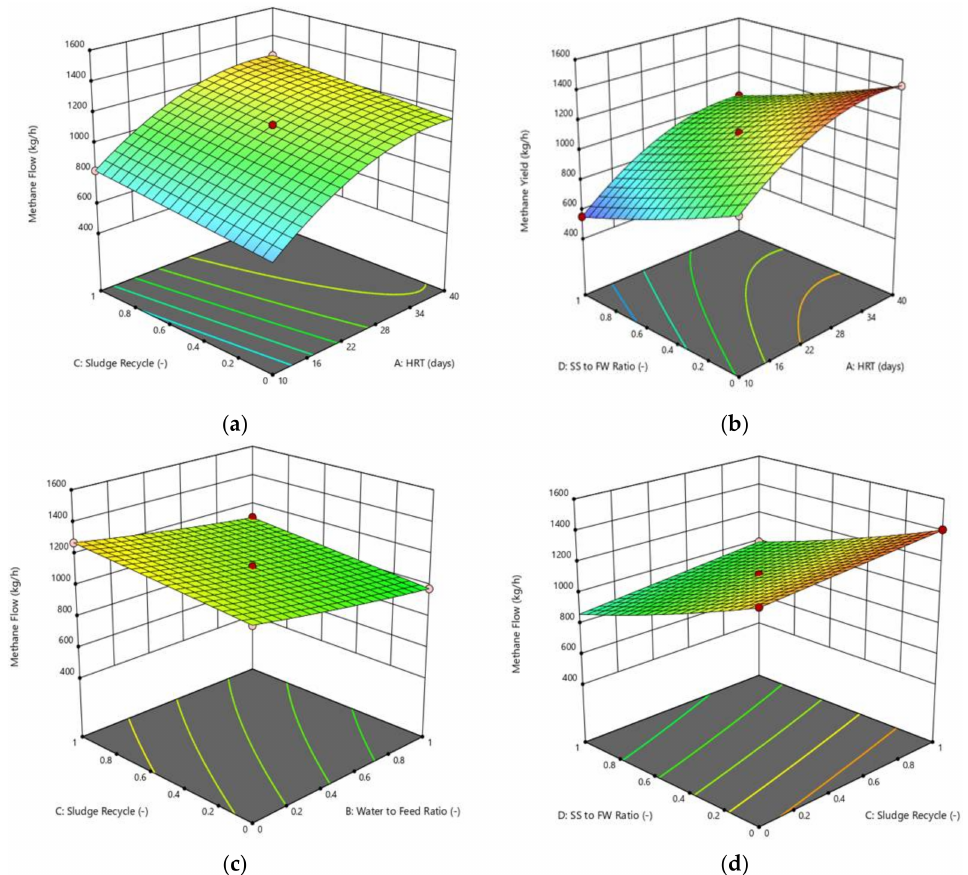
Figure 3. 3D surface graph plot for methane flow as a function of ( a ) HRT and sludge recycle ratio; ( b ) HRT and SS to FW ratio; ( c ) water to feed ratio and sludge recycle ratio; ( d ) sludge recycle ratio and SS to FW